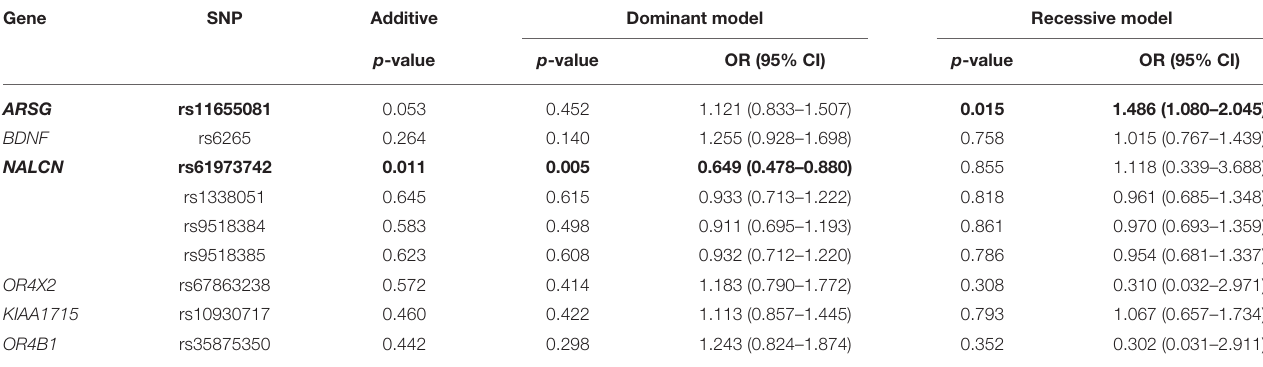
TABLE 3 | Genotype distributions between patients and